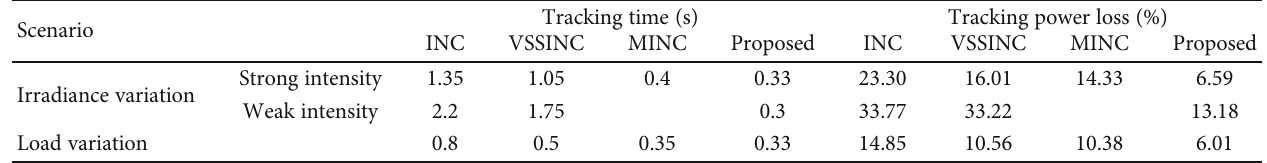
Table 4: E ffi ciency and steady state oscillation comparison of the proposed technique with other techniques. Scenario Irradiance variation Load variation One-day pro fi